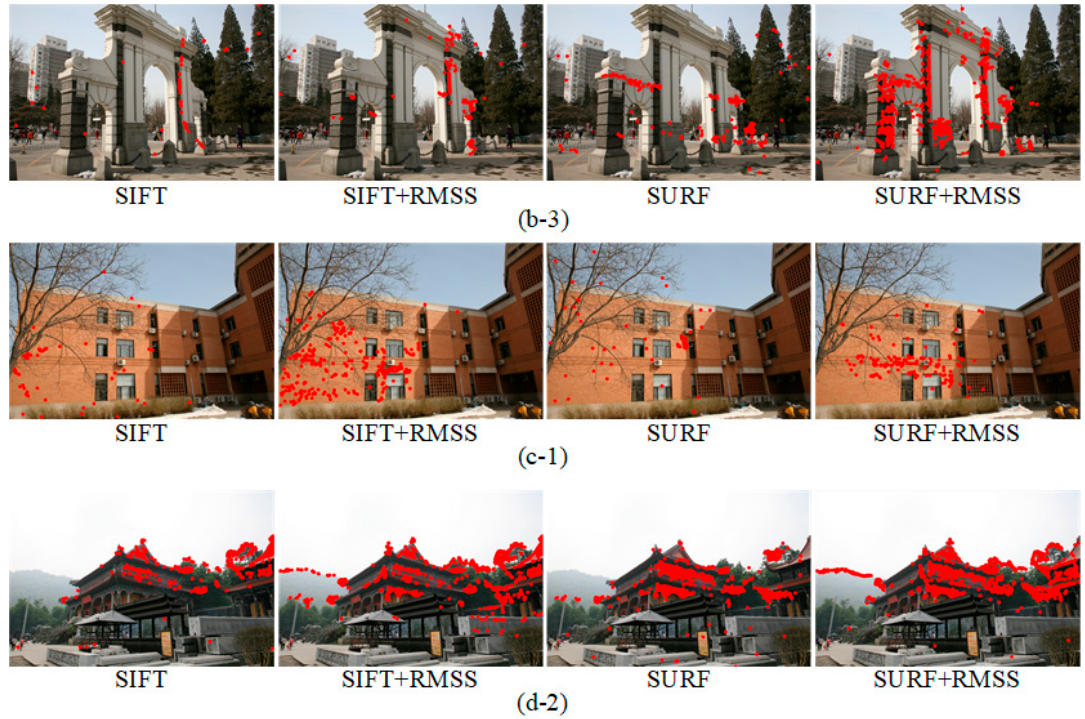
Figure 9. Inliers distributions before / after the optimization of the proposed method. ( b-3 ) is the stereo pair with the least inliers in Tsinghua gate dataset; ( c-1 ) is the stereo pair with the least inliers in Bioscience building dataset; ( d-2 ) is the stereo pair with the least inliers in Zhantan temple dataset.